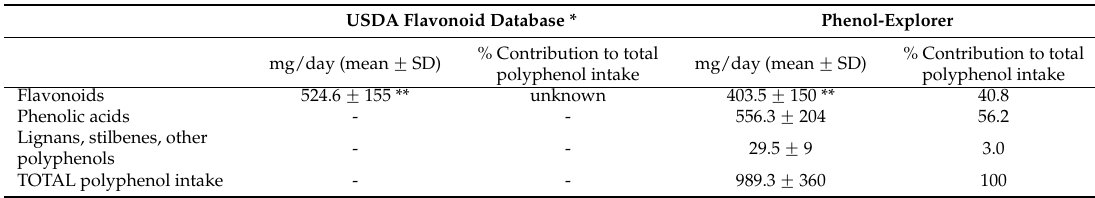
Table 2. Polyphenol intake (mg/day) in the studied population ( n = 6661).